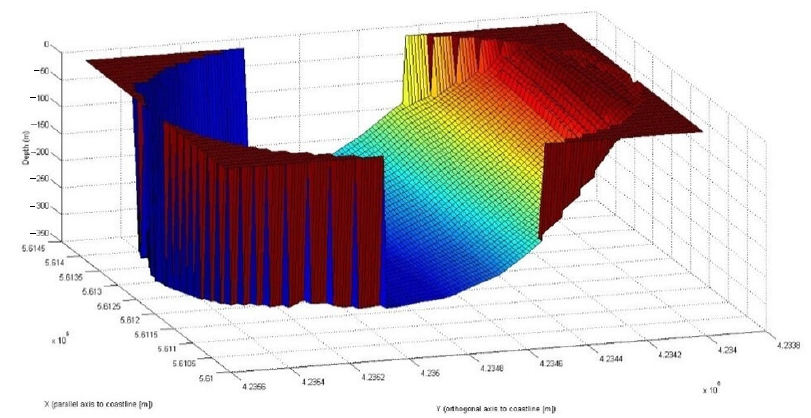
Figure 18. Landslide modeling at time T = 15 s.